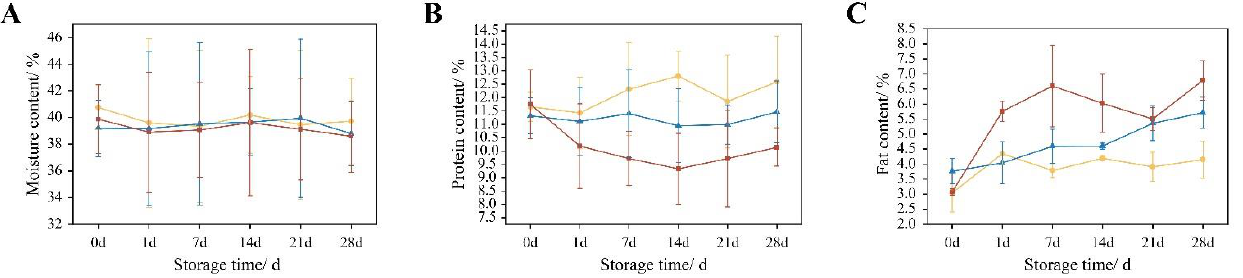
Figure 7. Changes in the basic nutritional quality of lamb liver paste during storage. Note: yellow represents the natural fermentation group (NF); blue represents the starter fermentation group (SF); red represents the sterilization group (ST). ( A ) represents the change of the moisture content of the lamb liver paste with the storage time, ( B ) represents the change of the protein content of the lamb liver paste with the storage time, and ( C ) represents the change of the fat content of the lamb liver paste with the storage time.